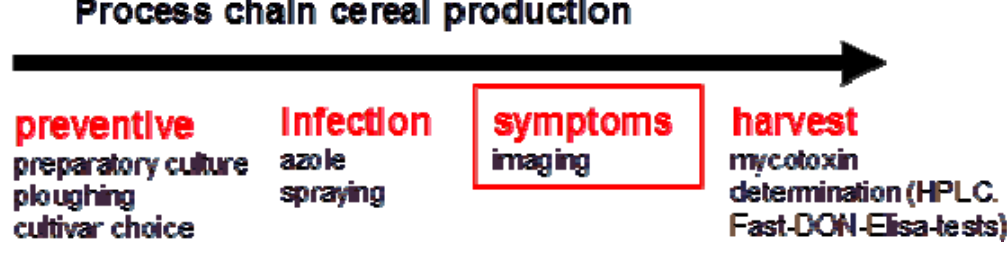
Figure 1. Options to prevent Fusarium infection in the cereal production